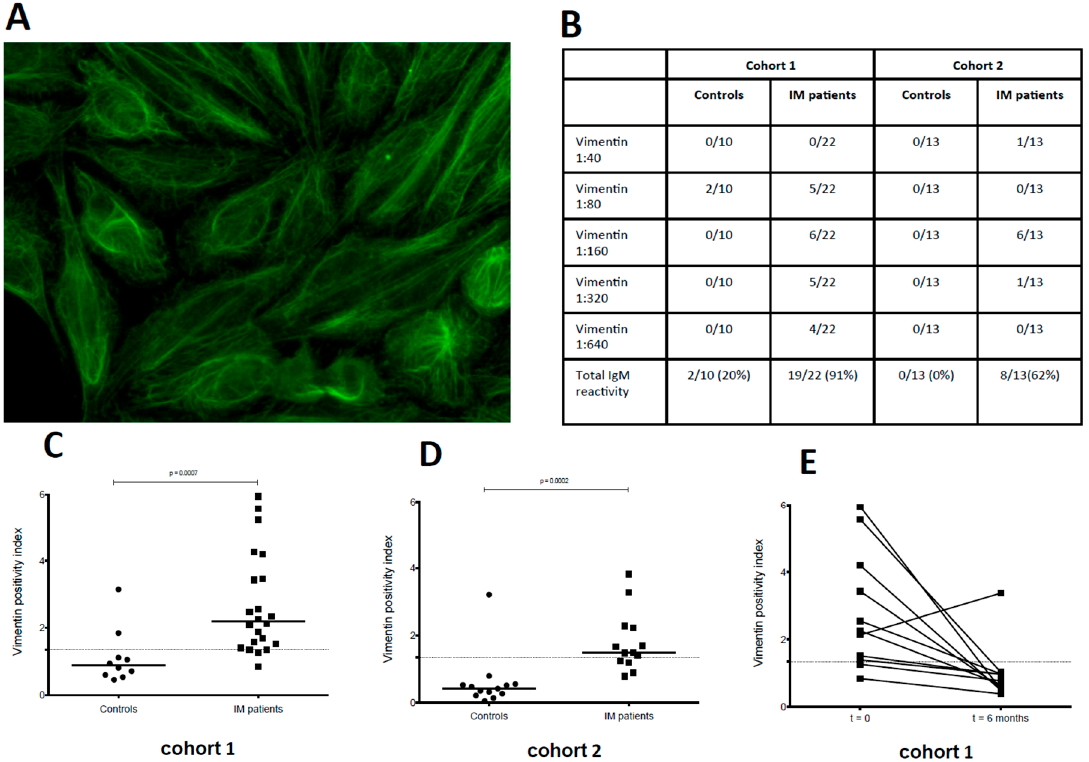
Figure 2. Transient IgM autoreactivity during acute IM. HEp-2 immunofluorescence staining was performed with serum derived from IM patients and control subjects from both cohorts. ( A ) HEp-2 positive vimentin-like staining of one representative IM patient. ( B ) Summary table of elevated IgM reactivity to vimentin during acute IM observed in both cohorts. ( C ) and ( D ) ELISA detection of anti-vimentin IgM autoantibodies in IM patients was significantly elevated compared to controls in both cohorts. ( E ) Longitudinal samples collected from IM patients in cohort 1 revealed decrease in anti-vimentin IgM antibodies six months post diagnosis of acute IM.